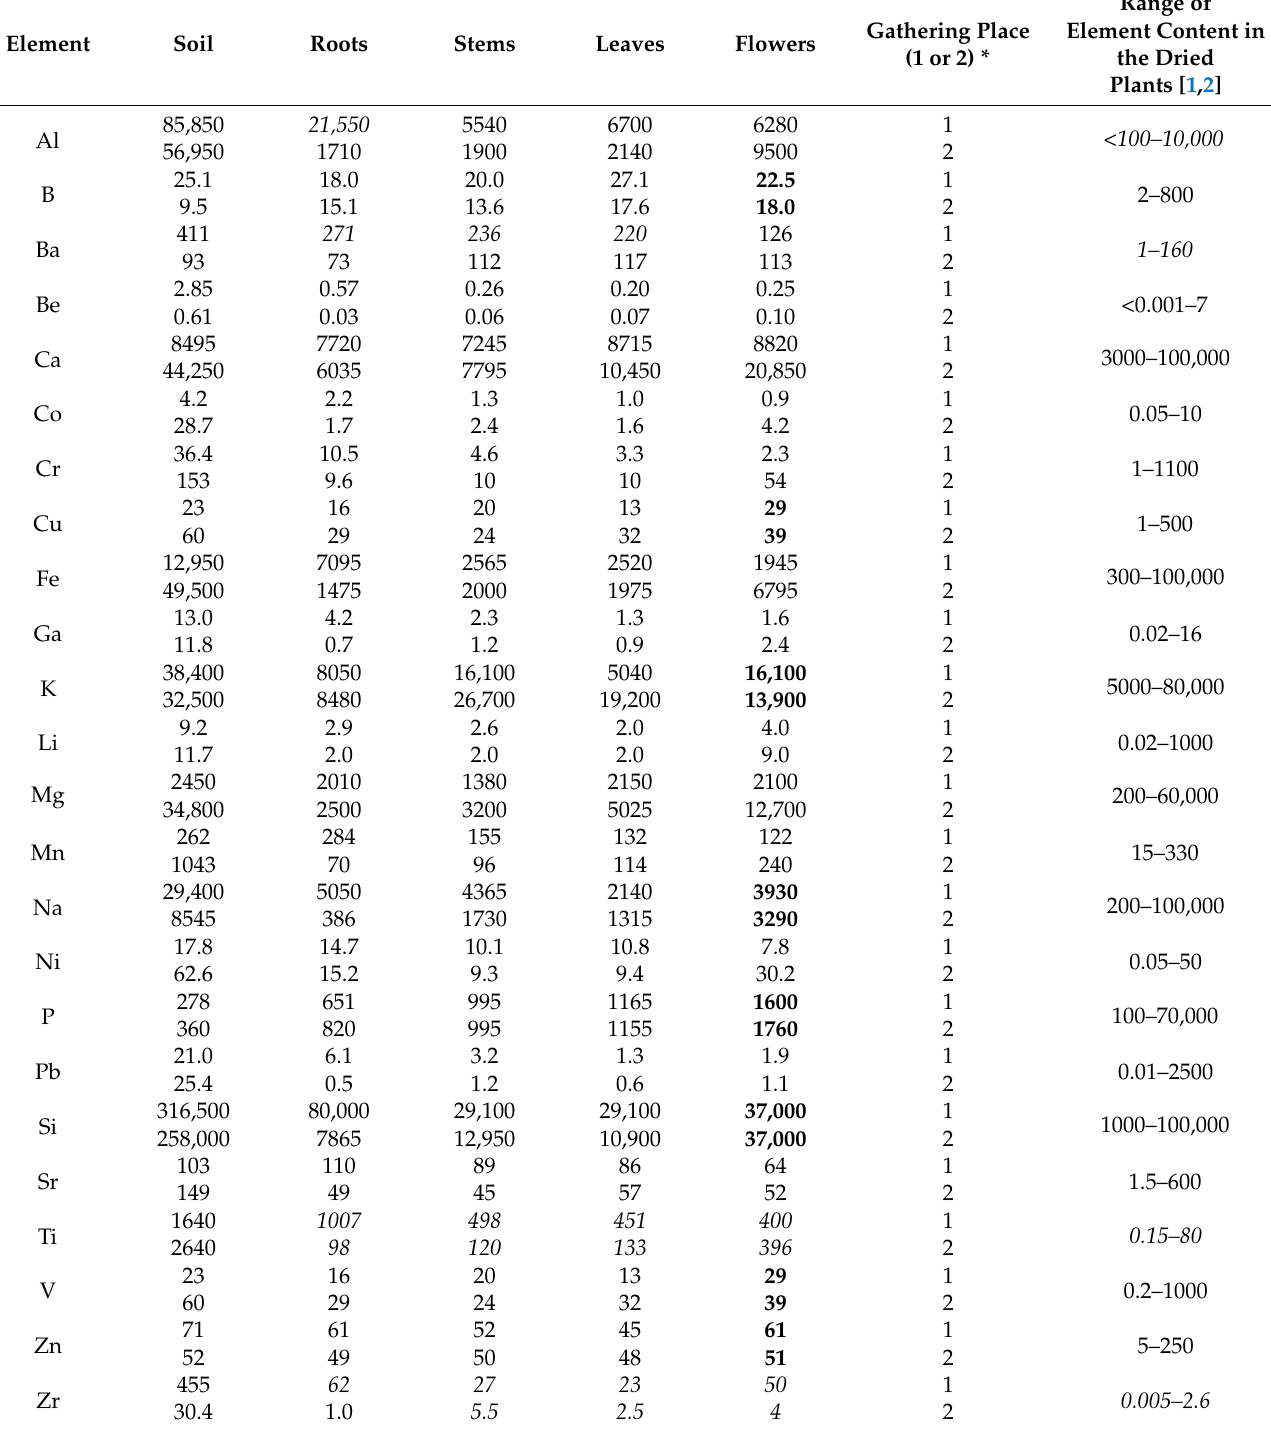
Table 1. Element contents (mg/kg) in soils and the dried plant organs of Thymus L. species ( n =